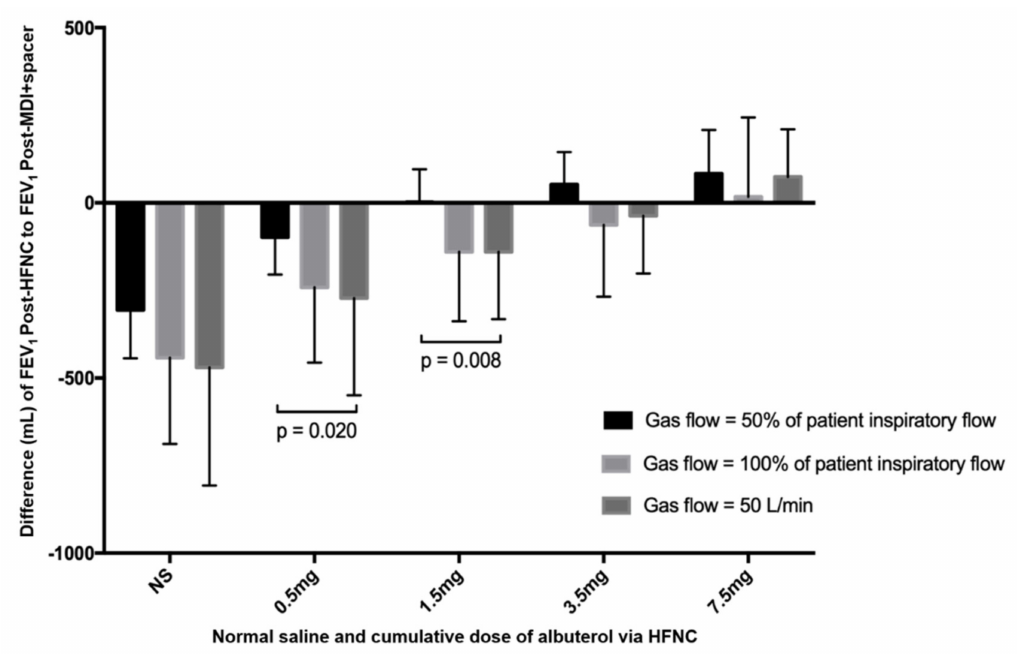
Figure 2. The difference of post-screening FEV 1 and FEV 1 after inhaling saline and salbutamol via HFNC at different nominal doses in three groups. FEV 1 post-MDI + VHC was deemed the highest observed FEV 1 for individual patients. Using the difference between the post-screening FEV 1 and each FEV 1 after inhaling saline and salbutamol via HFNC at different nominal doses to compare among three groups (ANOVA test), no significant difference was found after inhaling saline. While at the cumulative doses of 0.5 mg and 1.5 mg, the difference from post-screening FEV 1 in the group of GF:IF = 0.5 was smaller than the other two groups, this difference became nonsignificant at the cumulative doses of 3.5 mg and 7.5 mg. Scheme 0. had a smaller FEV 1 difference than GF = 50 L/min after inhaling salbutamol of 0.5 mg ( p = 0.023) and 1.5 mg ( p = 0.018) while no significant differences were found between GF:IF = 1.0 and GF = 50 L/min. FEV 1 , forced expiratory volume in the first second; HFNC, high-flow nasal cannula; MDI, metered dose inhaler; VHC, valved holding chamber; GF, gas flow; IF, inspiratory